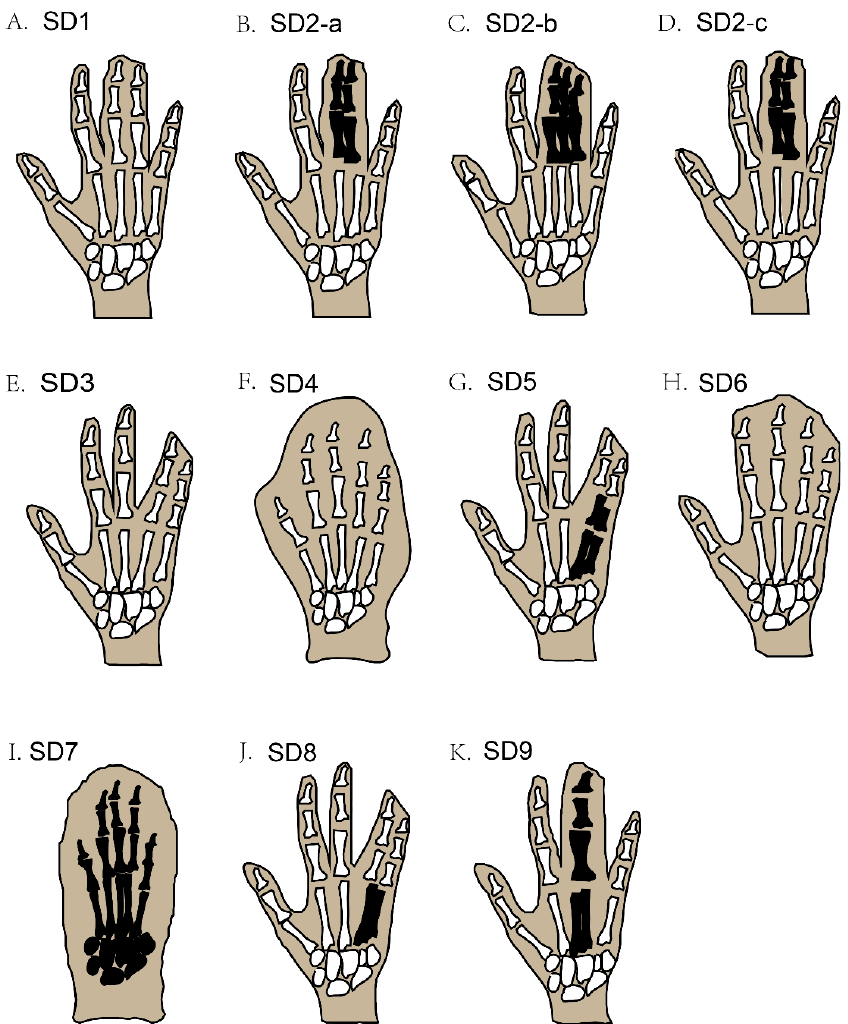
Figure 2. Schematic diagram of different types of non-syndromic syndactyly (types 1–9). Black- coloured areas represent the blending of the bones under webbed skin, while white-coloured areas under webbed skin represent unfused bones.